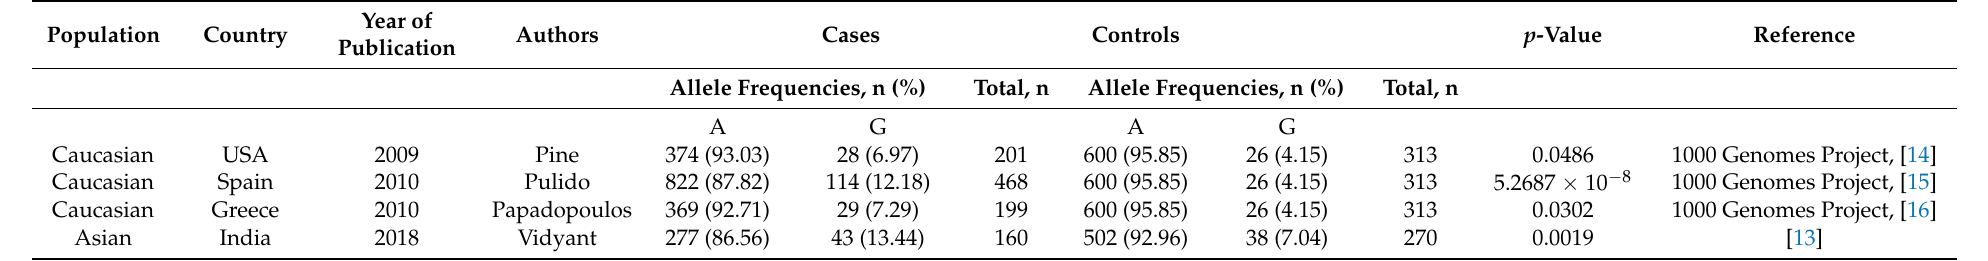
Table 1. Comparison of allele frequencies of rs4986790 (D299G) in the toll-like receptor 4 ( TLR4 ) gene between human immunodeficiency virus (HIV)-infected patients in previous studies and matched control populations obtained from the 1000 Genomes